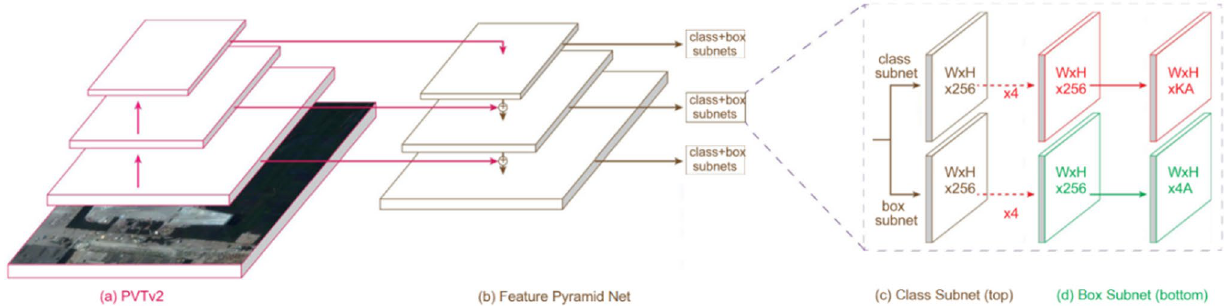
Fig. 1 The architecture of YOLF-ShipPnet network diagram of the